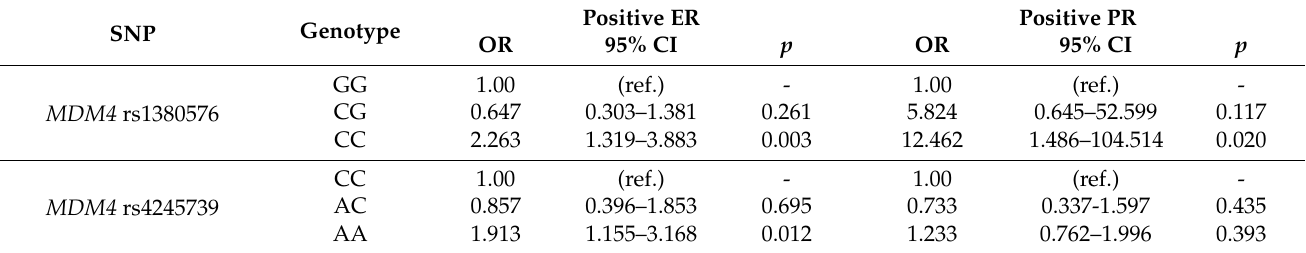
Table 6. Odds ratio for associations of rs1380576 G>C and rs4245739 C>A with tumor characteristics. SNP